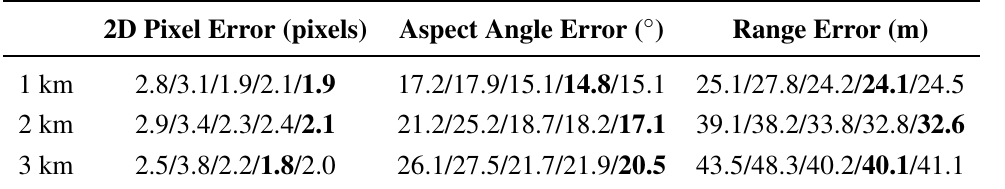
Table 1. Pose and location estimation errors for all five tested methods averaged over SENSIAC mid-wave IR sequences for each target to sensor distances depicting eight difference targets (Method I/Method II/Method III/Method IV/Method V).